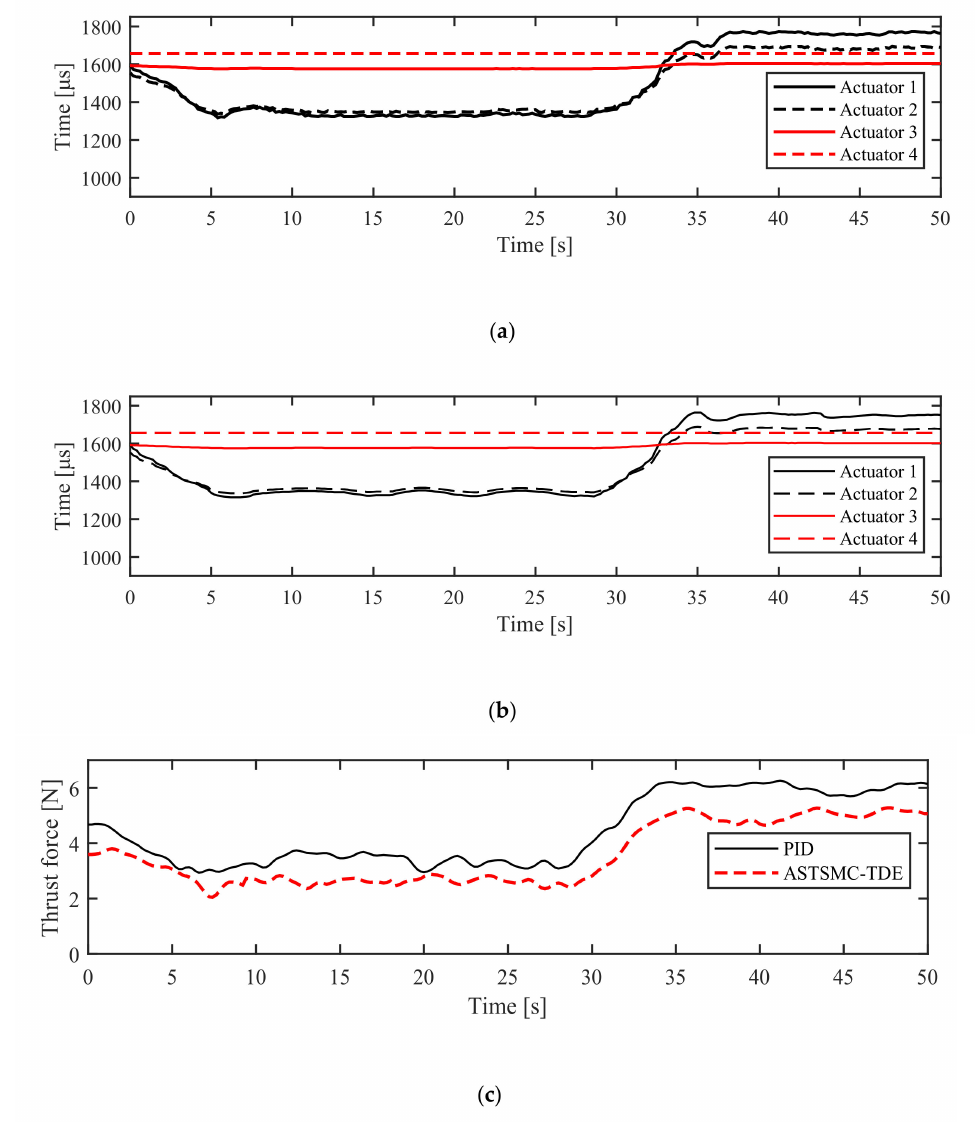
Figure 30. The experimental performance of the actuators in NM mode: ( a ) The control gains of actuators with the proposed controller; ( b ) Control gains of actuators with the PID; ( c ) Thrust force generated by BLDC.